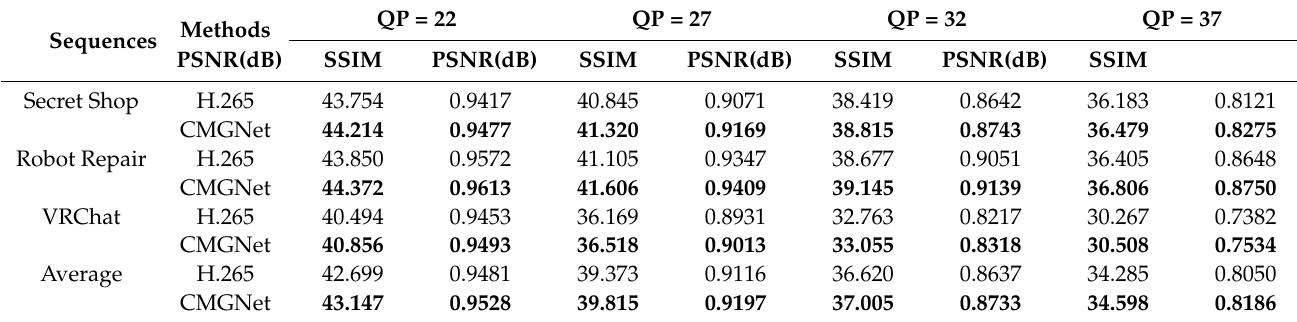
Table 3. Quantitative performance on PSNR and SSIM at four QPs.